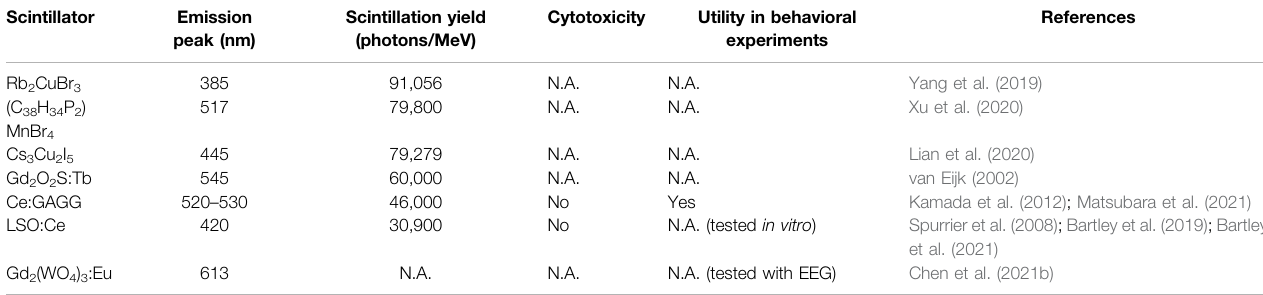
TABLE 1 | Non-hygroscopic scintillators for X-ray-mediated optogenetics.